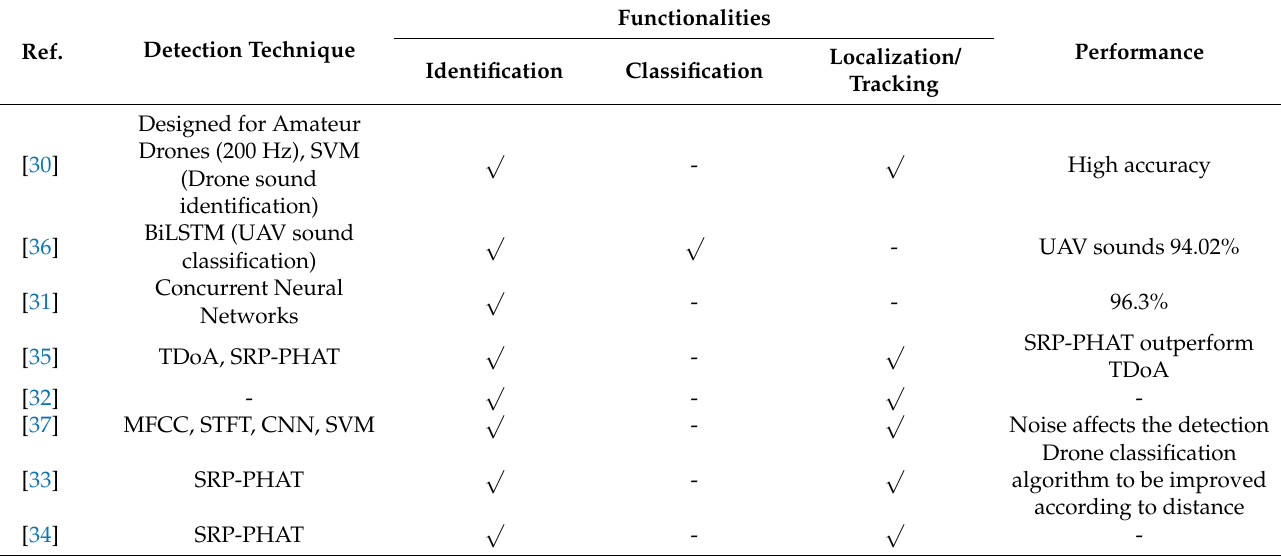
Table 4. Summary of reviewed acoustic-based techniques for UAV characterization.